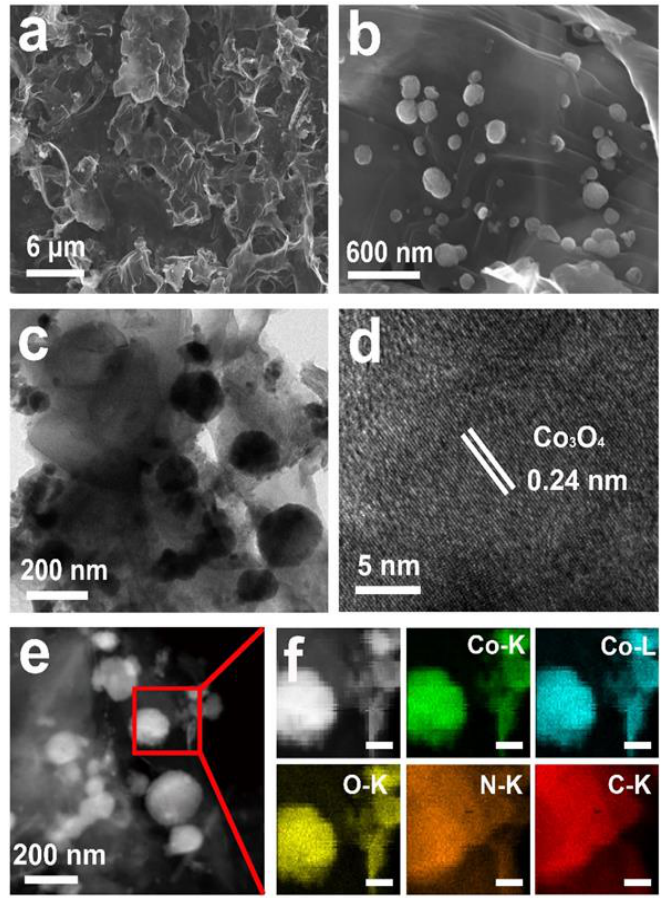
Figure 1. ( a ) SEM image, ( b ) Enlarged SEM image, ( c ) TEM image and ( d ) HRTEM image of Co 3 O 4 /C − 750. ( e ) HAADF-STEM image and ( f ) relevant element analysis diagram of Co 3 O 4 /C − 750 (scale bar for illustration: 50 nm).